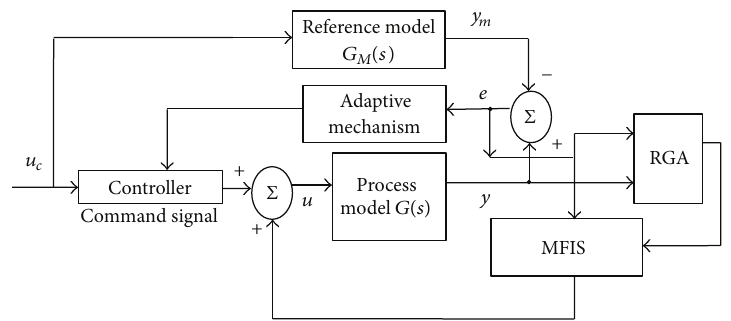
Figure 2: Controller tuning using RGA.